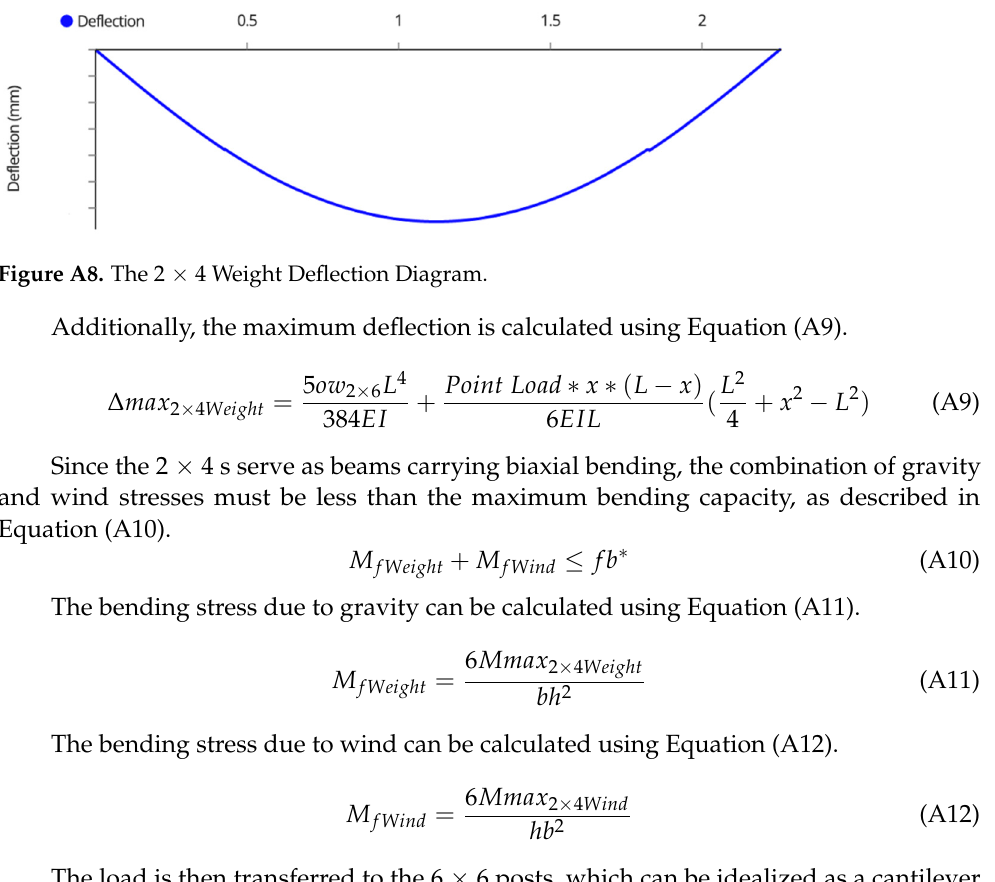
The deflection diagram is shown in Figure A8.